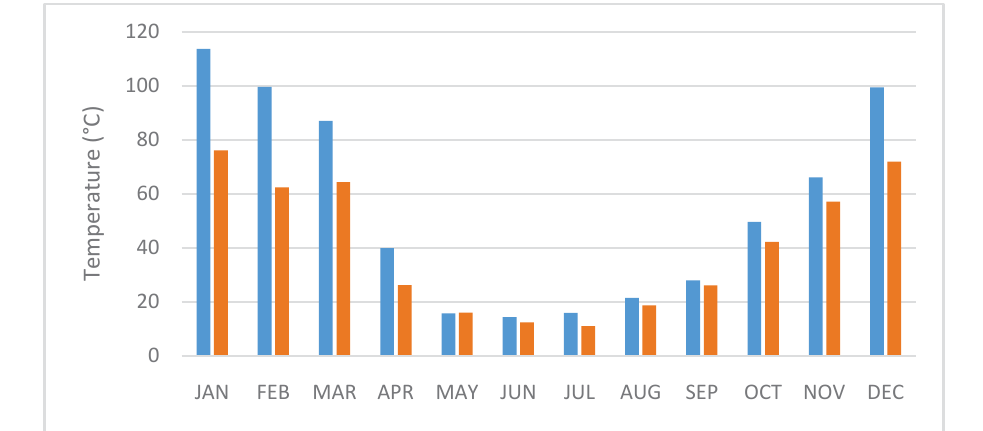
Fig. 10. Plot of average monthly humidity at the two weather stations